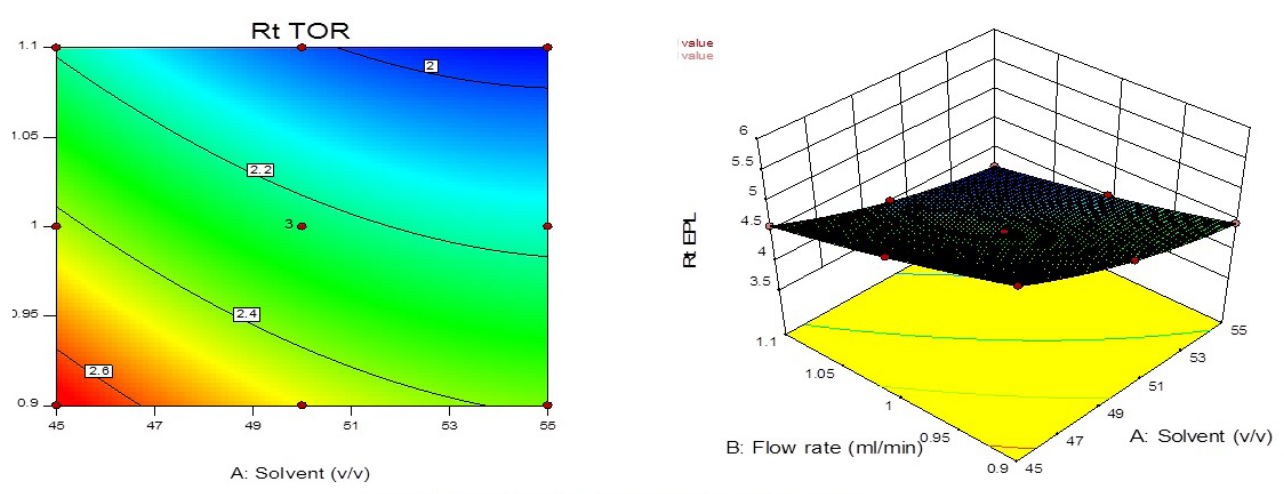
FIGURE 3 - 2D (A) and 3D (B) contour plots showing the effect of mobile phase ratio (X of TOR (Y 1